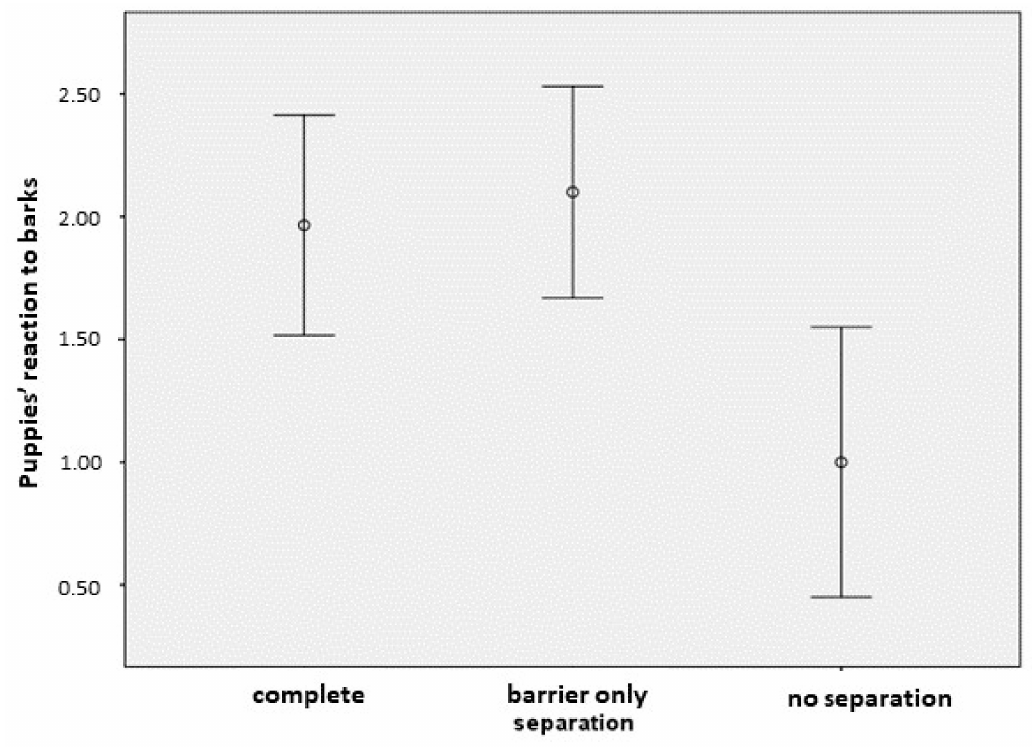
Figure 1. Association between the housing method of the puppies (“separation” 1–3 shows a decreasing level of isolation of the puppies from other dogs) and their reaction to other dogs’ barking (mean ± 95% confidence interval (CI)).